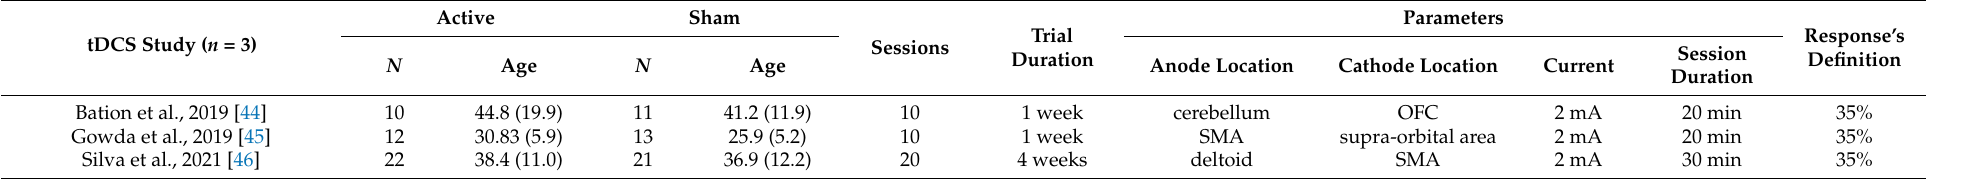
Table 2. Main characteristics of the included studies